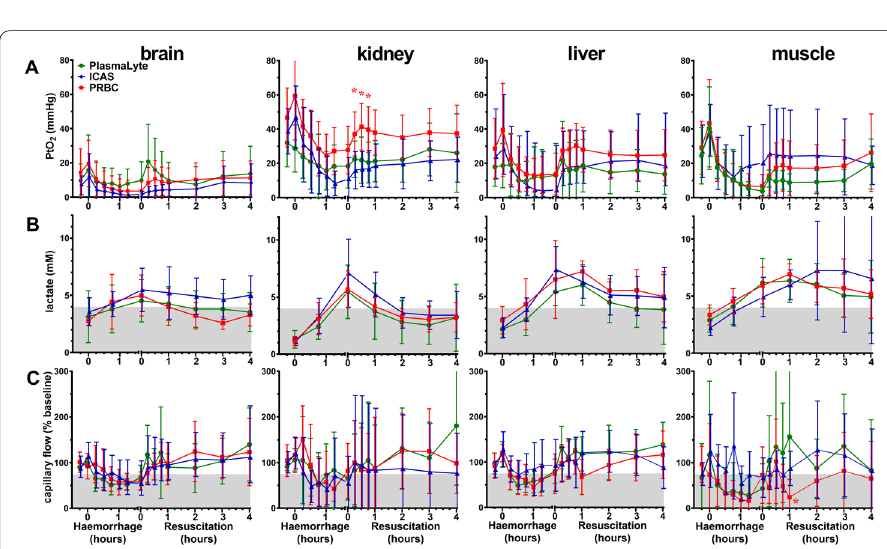
Fig. 4 Invasive measures of oxygen tension, lactate concentration and microvascular blood flow in brain, kidney, liver and muscle. A Organ‑specific oxygen tension (PtO 2 ). B Organ‑specific lactate concentration. C Organ‑specific microvascular blood flow. Data shown as mean or geometric mean according to normality test, with 95% confidence intervals. Mixed model ANOVA with Tukey correction for multiple comparisons; * p <